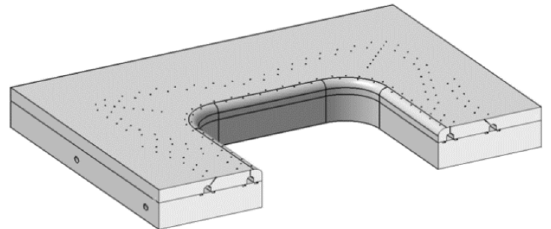
Fig. 2. Cross section through the segmented die of the deep drawing tool.